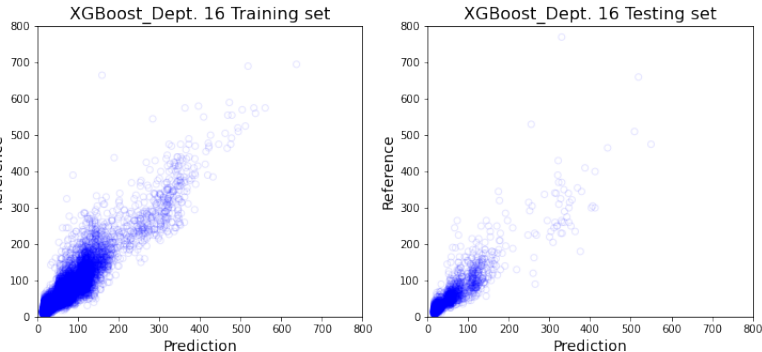
Figure A12. Model Performance of XGBoost on Dept.16. The visualization of training and testing data for department specific model on department 16 with